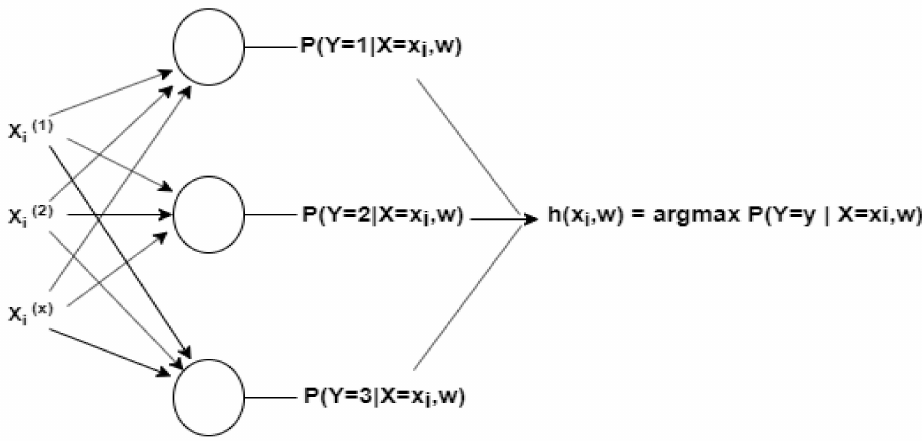
Figure 2. The basic working mechanism of a multiclass artificial neural